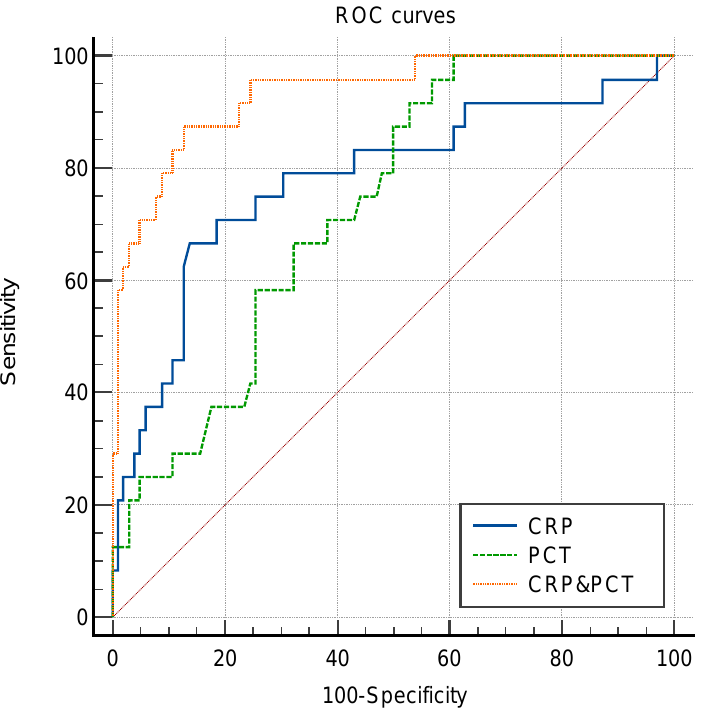
Figure 2. ROC curves of CRP, PCT, and CRP&PCT. ROC: receiver operating characteristic; CRP: C-reactive protein; PCT: procalcitonin. Table 3. Performance characteristics of CRP, PCT, and the combination of CRP and PCT in diagnos- ing the IFI.